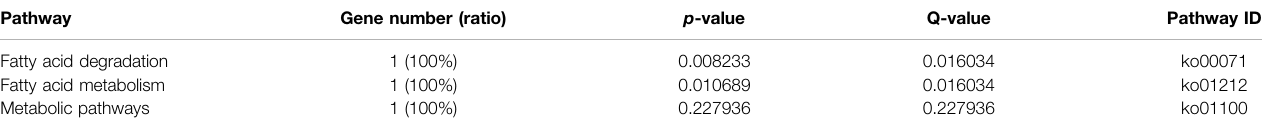
TABLE 4 | KEGG enrichment for strong positive select genes by comparing Zeugodacus cucurbitae (Coquillett) and Bactrocera dorsalis (Hendel). Pathway